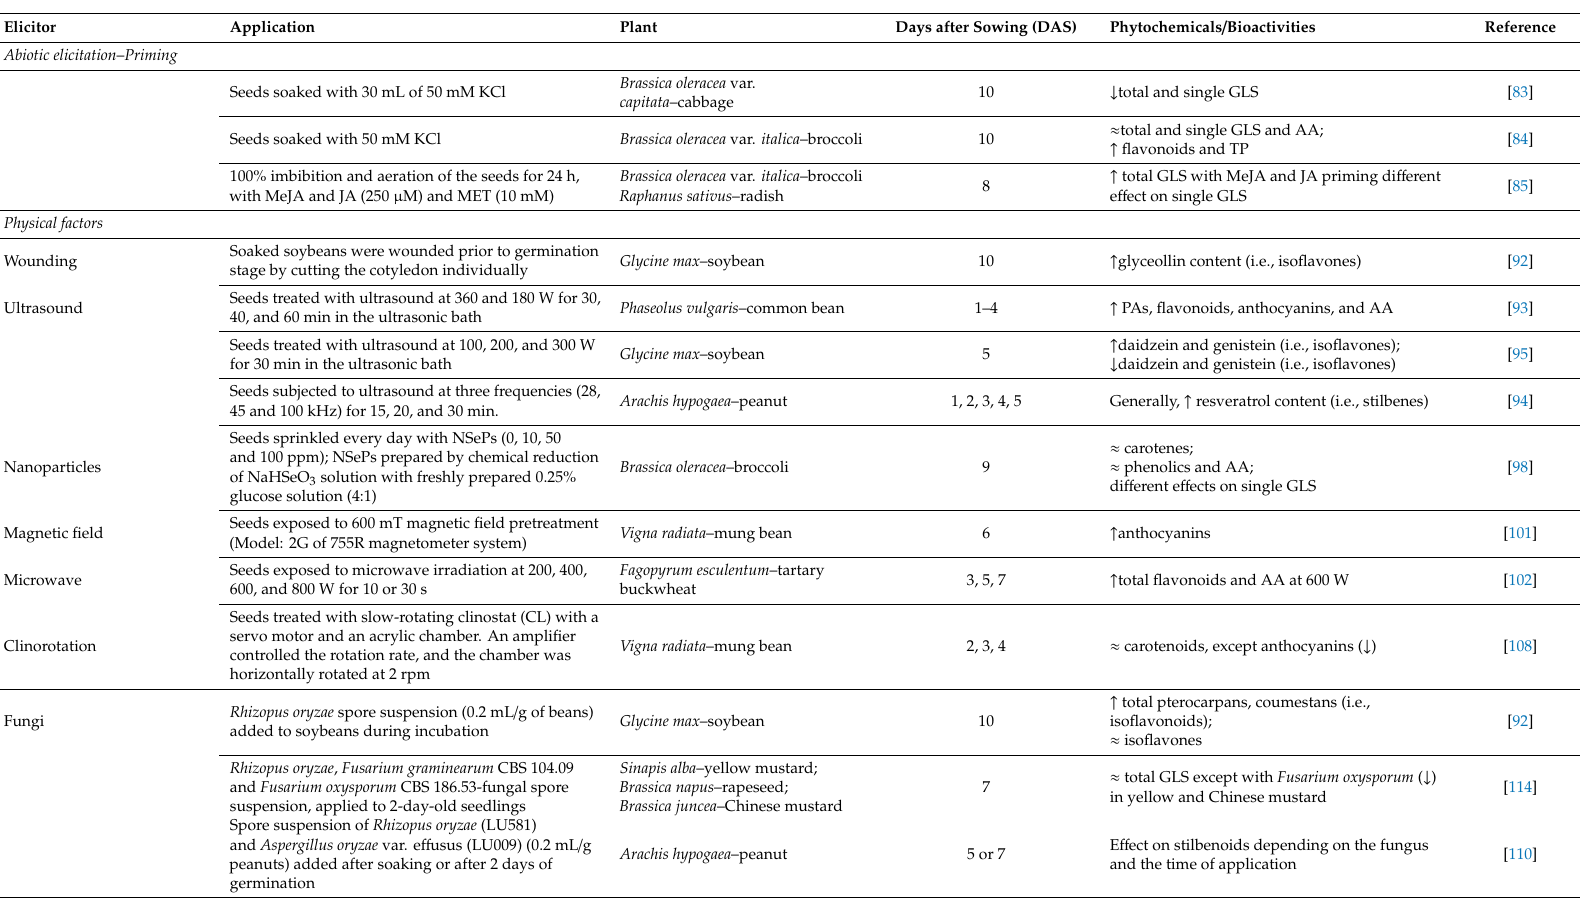
Table 4. Biotic and abiotic elicitation strategies to raise phytochemical content and corresponding bioactivities in micro-scale vegetables.